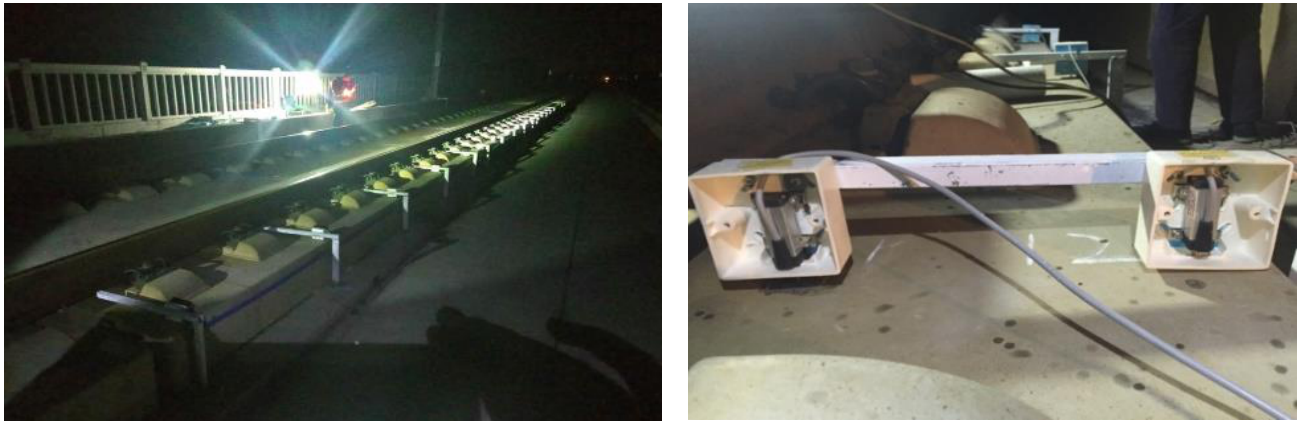
Figure 12. The installation of sensors for the field test.